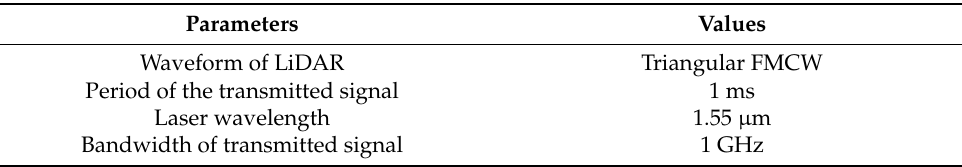
Table 2. Parameters of FMCW LiDAR